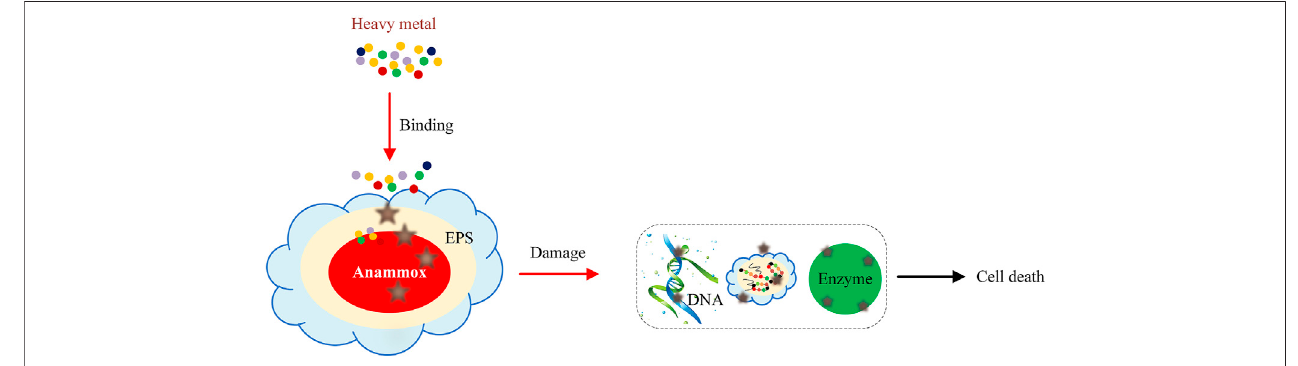
FIGURE 1 | Effects of heavy metals on